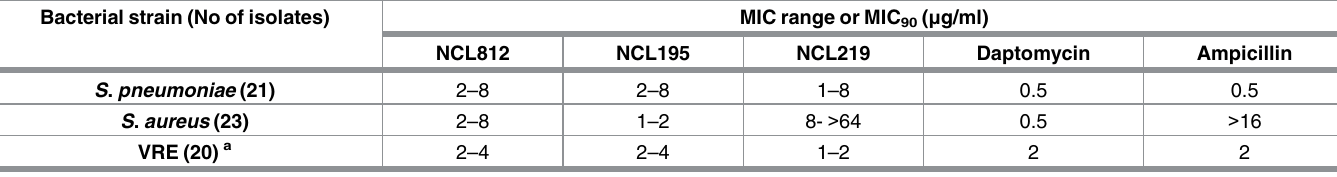
Table 1. MIC range values for NCL812, NCL195 and NCL219 compared to MIC 90 values for daptomycin and ampicillin against S . pneumoniae , S . aureus and vancomycin resistant enterococci (VRE). Bacterial strain (No of